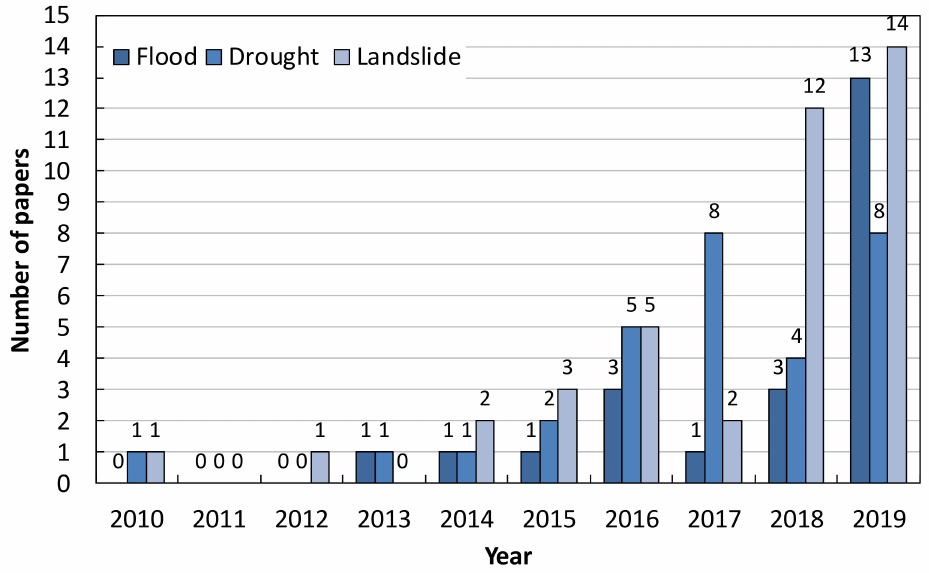
Figure 5. The relationship between year and number of papers for three